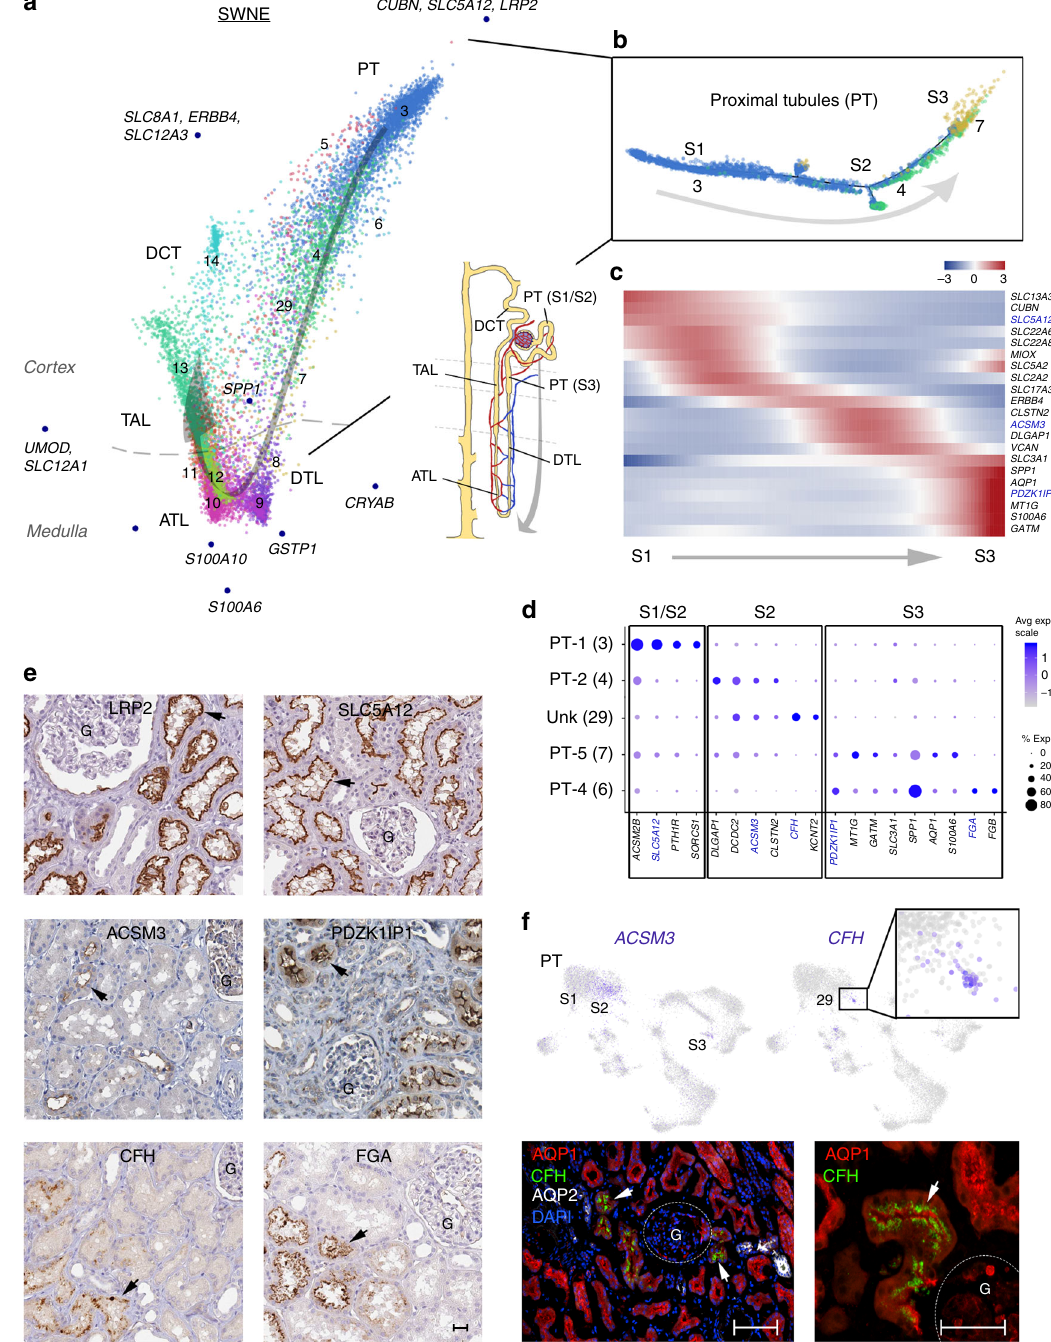
Fig. 3 Proximal tubule cell populations. a SWNE analysis of tubule clusters (3 – 14, 29) for cell types indicated (PT, DTL, ATL, TAL to DCT). Arrow indicates progression of lineages corresponding with expected spatial ordering in vivo. SWNE factor-associated genes (Supplementary Data 9) and relative medulla/ cortex originations are indicated. b . Trajectory analysis of main PT clusters supporting their S1, S2 and S3 PT segment identities. c Heatmap of expression (row Z-scores) for genes differentially expressed along the proximal tubule trajectory (Supplementary Data 10) shown in ( b ). d Dot plot showing select segment-speci fi c marker gene expression (averaged log scale values and percentage of expressed nuclei), localizing the PT clusters Unk and PT-4 to S2 and S3 segments. e Protein immunostaining (Human Protein Atlas 49 , Supplementary Data 16) for select PT markers, including general PT (LRP2), segment-speci fi c (highlighted in c ), and Unk/PT-4 cluster (CFH and FGA) markers. Arrows indicate representative protein localization. Scale bar indicates 25 µ m. f UMAP plots as in Fig. 1b showing expression level (scaled from low — gray to high — blue) of S2 segment marker ACSM3 and Unk cluster 29 marker CFH . Lower panels show protein fl uorescent immunostaining (Supplementary Data 17) for CFH in a subset of PT co-stained with AQP1 expression in PT, but not the PC marker AQP2 (arrows). Location of glomeruli (G) and scale bars (left panel — 100 µ m; right panel — 50 µ m) are indicated. Source data for ( a − d , f ) (UMAP plots) are provided as a Source Data fi le. UMAP uniform manifold approximation and projection, SWNE Similarity Weighted